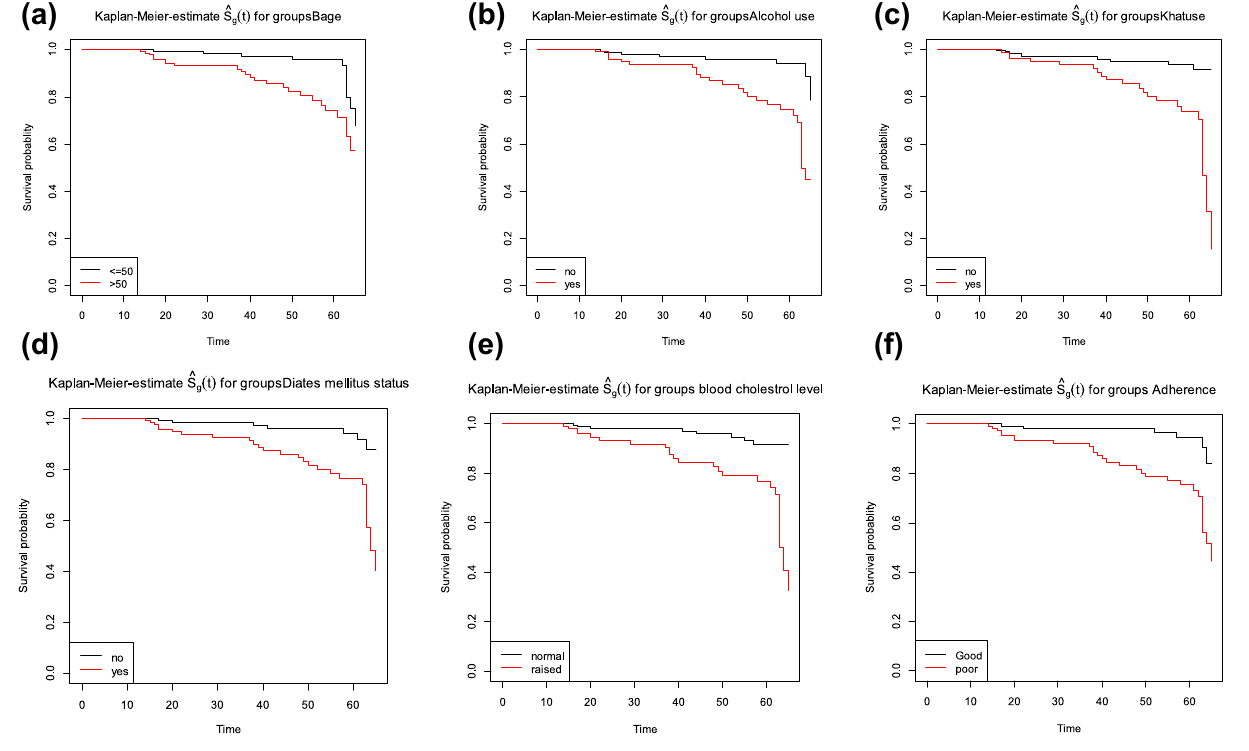
Figure 1. Plot of Kaplan–Meier survival function curves of hypertension patients ( a ) Age ( b ) Alcohol ( c ) Khat ( d ) diabetes Mellitus status ( e ) Cholesterol level ( f )